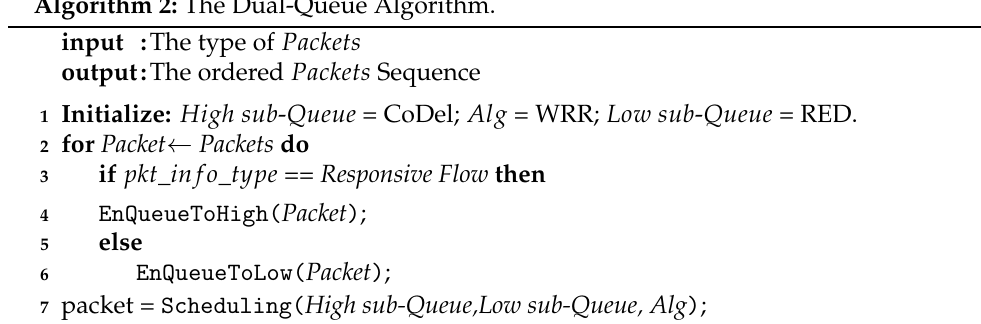
Algorithm 2: The Dual-Queue